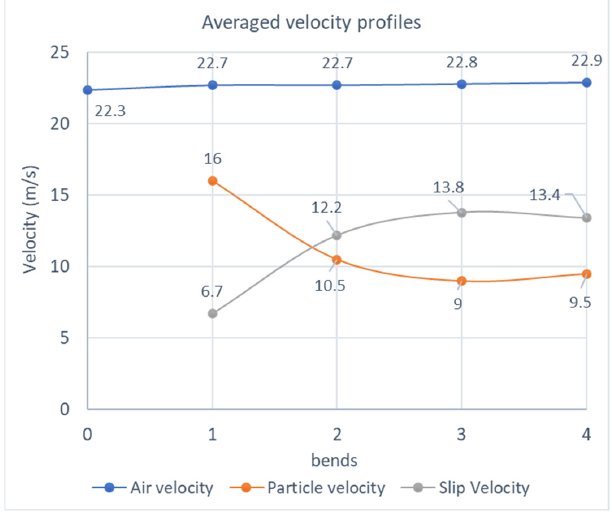
Figure 5. Velocity profiles at the inlet of the pipe and before bends with 0.24 kg/s air flow rate and 0.2 kg/s solid flow rate.